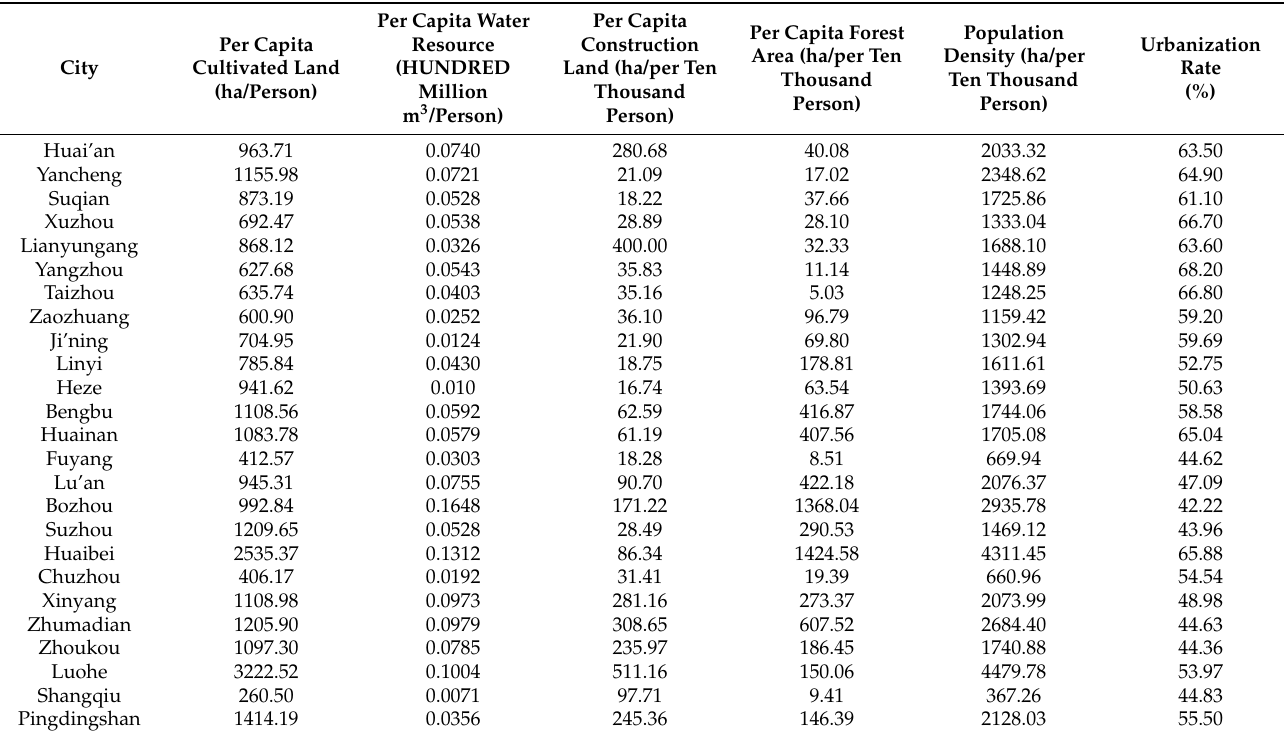
Table A1. Raw data of various indicators of the evaluation